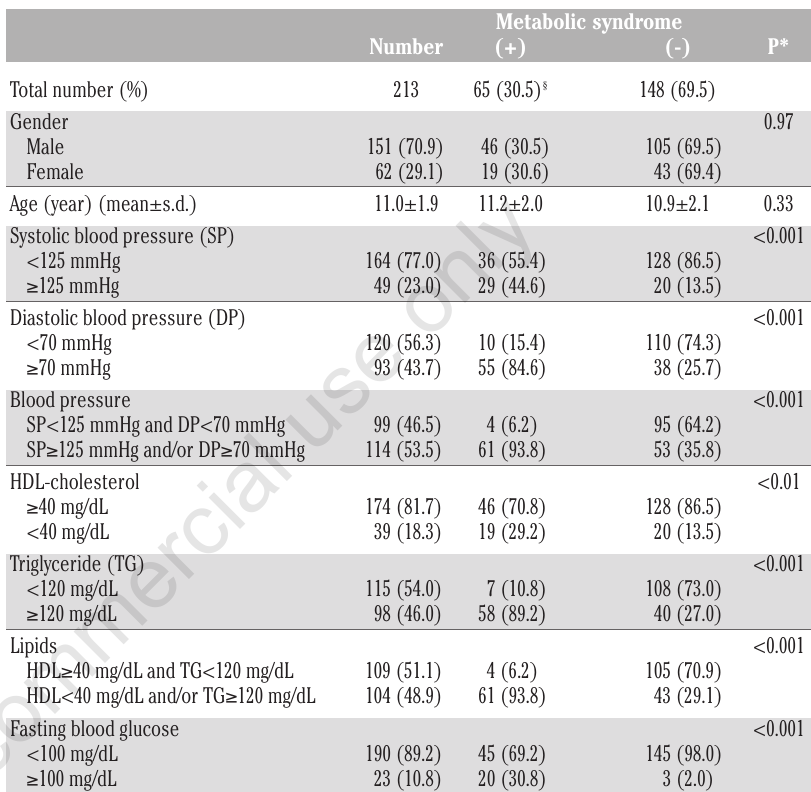
§Numbers in parentheses indicate the percentage; * c 2